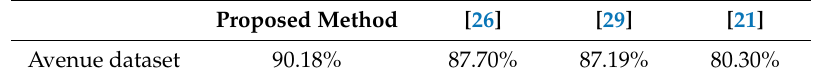
Figure 10. Examples of detection results for abnormality from No. 3 data (UMN Scene 3: Plaza). Table 3. AUC (area under the curve) comparison with state-of-the art methods on the Avenue dataset.